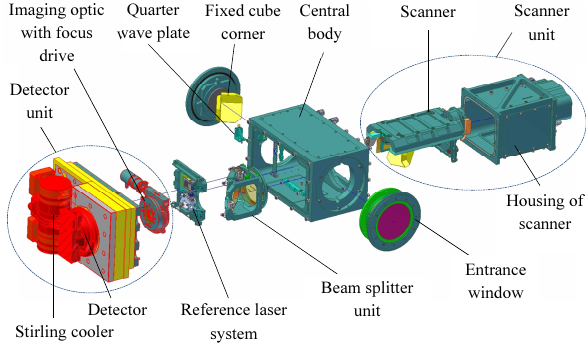
Figure 5. Exploded view of the optic module illustrating the main opto-mechanical (cyan) and optical components of the interferome- ter, the entrance window, the imaging optic and the detector system